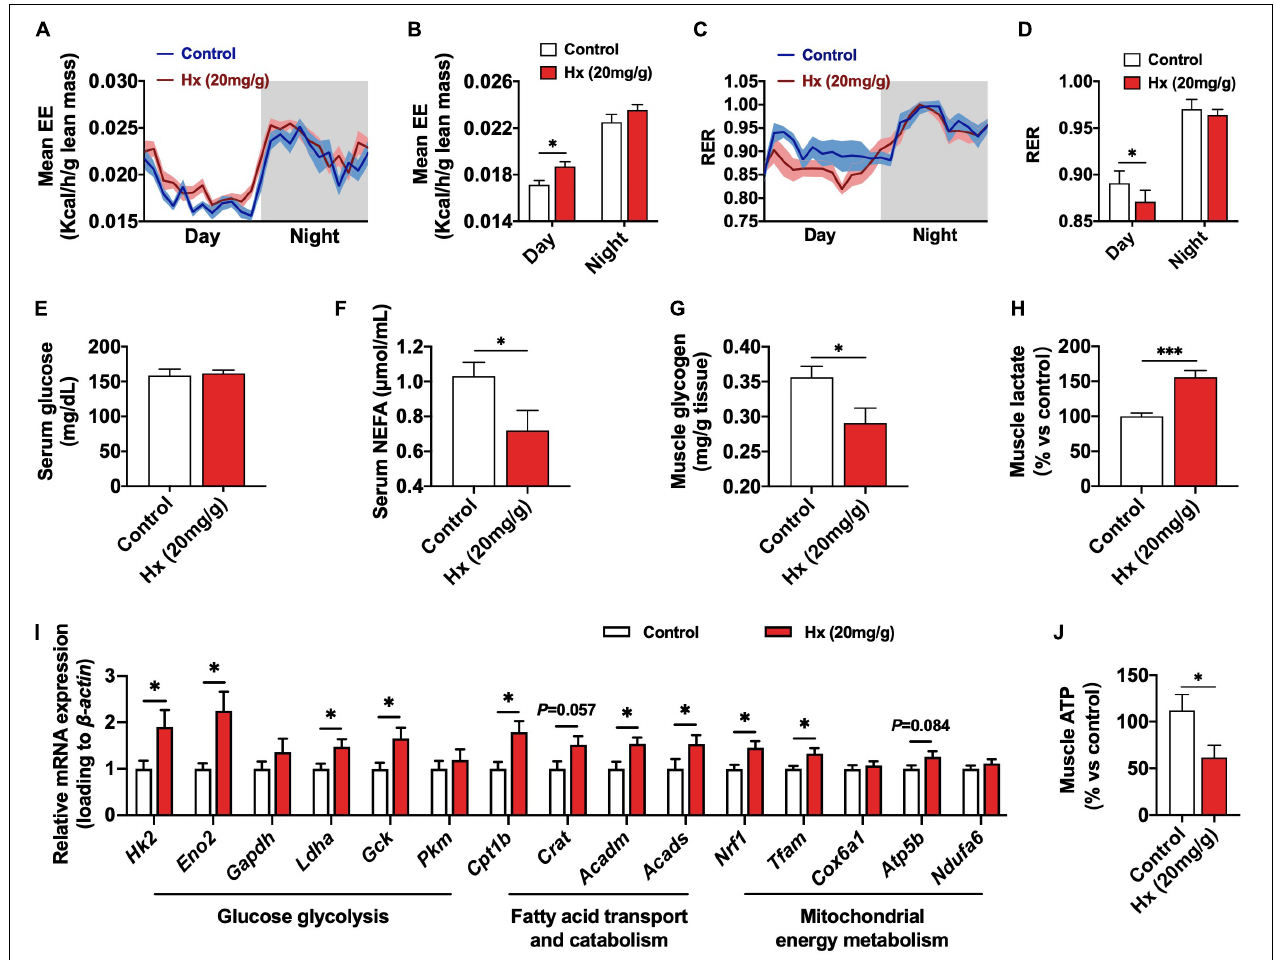
FIGURE 3 | Effects of Hx on the skeletal muscle energy metabolism. (A) EE of mice after 4 weeks Hx treatment. Grey areas indicate dark periods ( n = 8 mice per group). (B) Statistics of mean EE values of mice in night or dark cycle after 4 weeks Hx treatment ( n = 8 mice per group). (C) RER of mice after 4 weeks Hx treatment. Gray areas indicate dark periods ( n = 8 mice per group). (D) Statistics of mean RER values of mice in night or dark cycle after 4 weeks Hx treatment ( n = 8 mice per group). (E–H) Serum glucose (E) and NFFA (F) levels; GAS muscle glycogen (G) , and lactate (H) content of mice after 4 weeks Hx treatment ( n = 8 mice per group). (I) mRNA expression of genes related to the glucose glycolysis, fatty acid transport and catabolism, and mitochondrial energy metabolism of GAS muscle after 4 weeks Hx treatment ( n = 7–8 mice per group). (J) GAS muscle ATP content of mice after 4 weeks Hx treatment ( n = 8 mice per group). β -actin